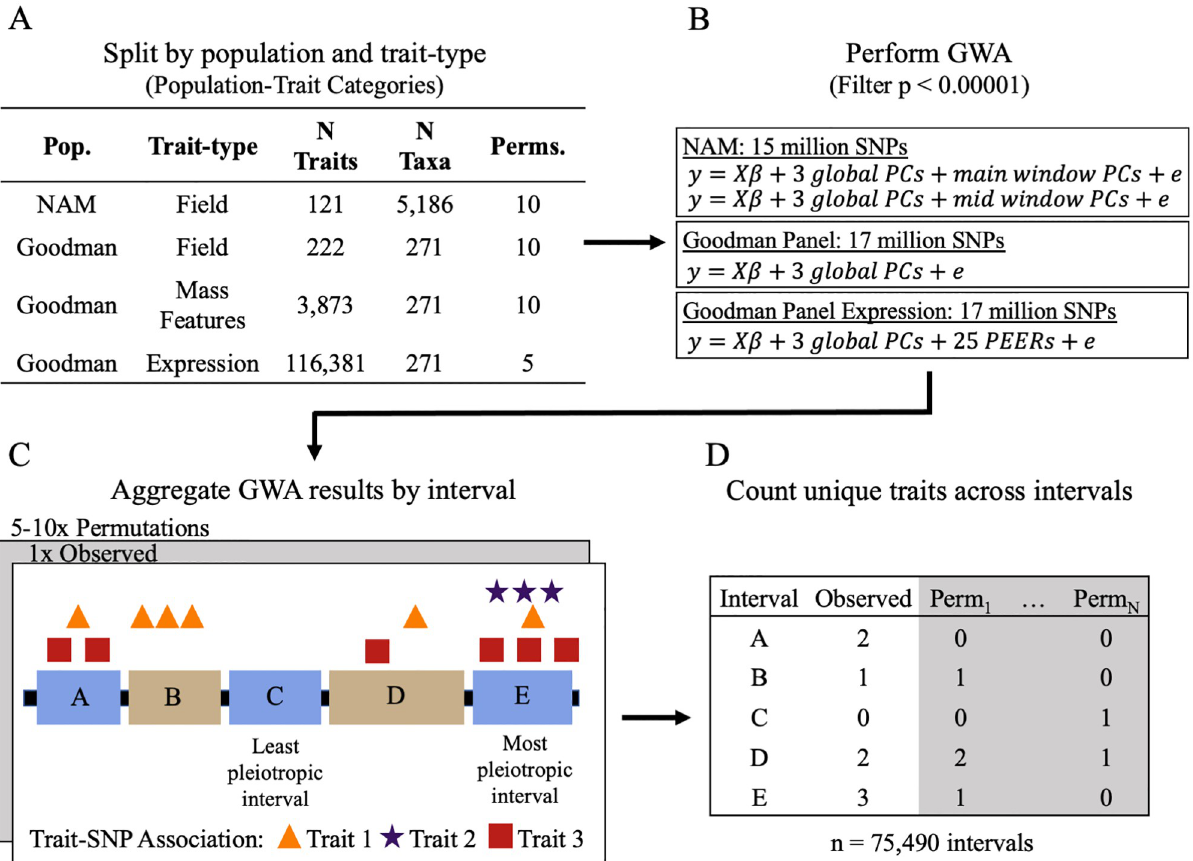
Fig 1. Schematic of the methods used within this study. (A) A total of 120,597 traits were gathered across four population-trait categories: 1) NAM field, 2) GAP field, 3) GAP mass features, and 4) GAP expression. Trait values were randomly shuffled (i.e., permuted) five or ten times to create null distributions of no pleiotropy. (B) The observed and permuted data were then mapped with the Fast Association method in rTASSEL on 15 million NAM SNPs and 17 million GAP SNPs using a combination of global and window principal components and PEER factors to control population structure and experimental design. All results with p-value < 0.00001 were kept for both the permuted and observed data. (C) GWAS results were then split by trait type and permutation and were then aggregated into genic and intergenic intervals based on the significant B73 v4 trait-SNP association coordinate. (D) A matrix of the number of unique traits mapping to each interval was used to estimate pleiotropy independently for each population- trait category.